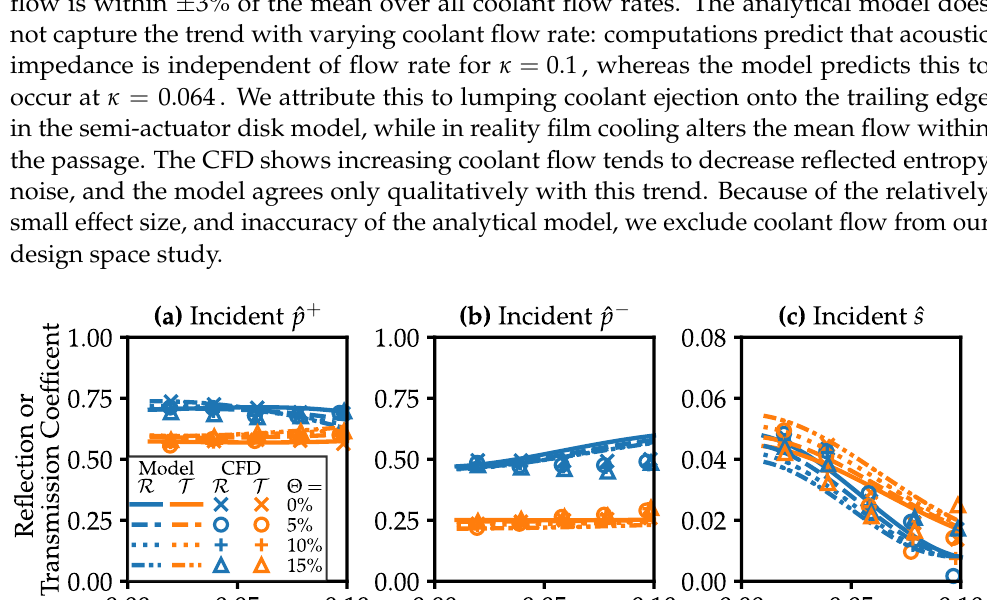
7% ± 16% for entropy–acoustic ±